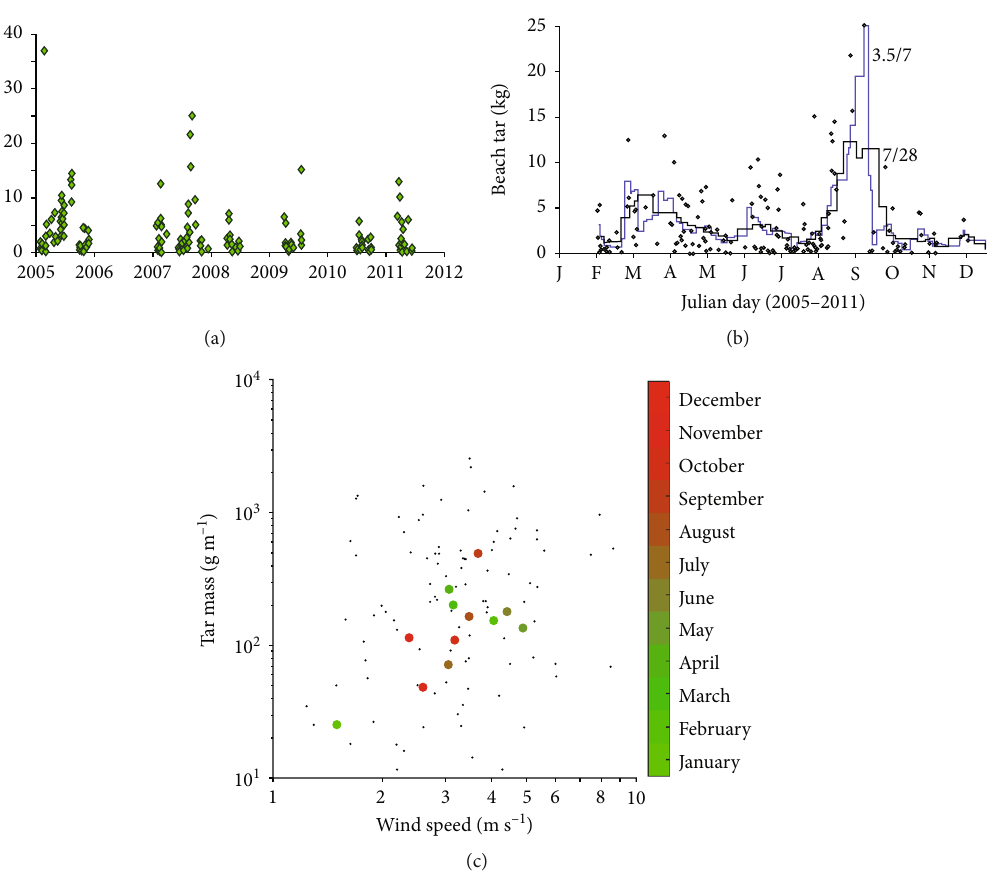
Figure 30: (a) Total beach tar accumulation for the Coal Oil Point study area. (b) Study area tar accumulation versus Julian day with 28-day smoothing with 75% overlap (7/28) and 7-day smoothing with 50% overlap (3.5/7), respectively. Low data density in late December-January re fl ects poor student availability. (c) Beach tar accumulation versus wind speed for individual and monthly averaged (Figure 31). This asymmetry re fl ects longshore current dif- ferences across COP and tar arrival from the west- southwest. Speci fi cally, COP protects Devereaux Beach, lead-